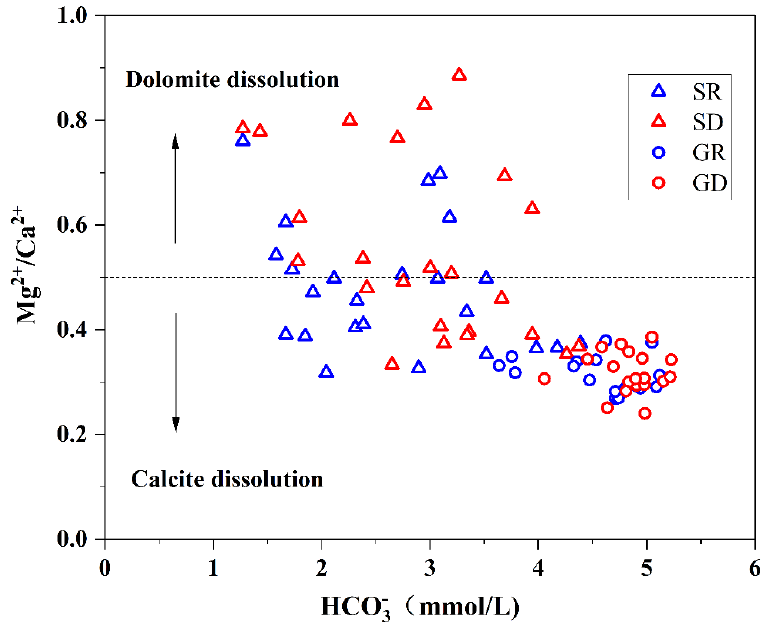
and Mg 2+ /Ca 2+ . Figure 9. Relationship between HCO − and Mg 2+ /Ca 2+ 3 3